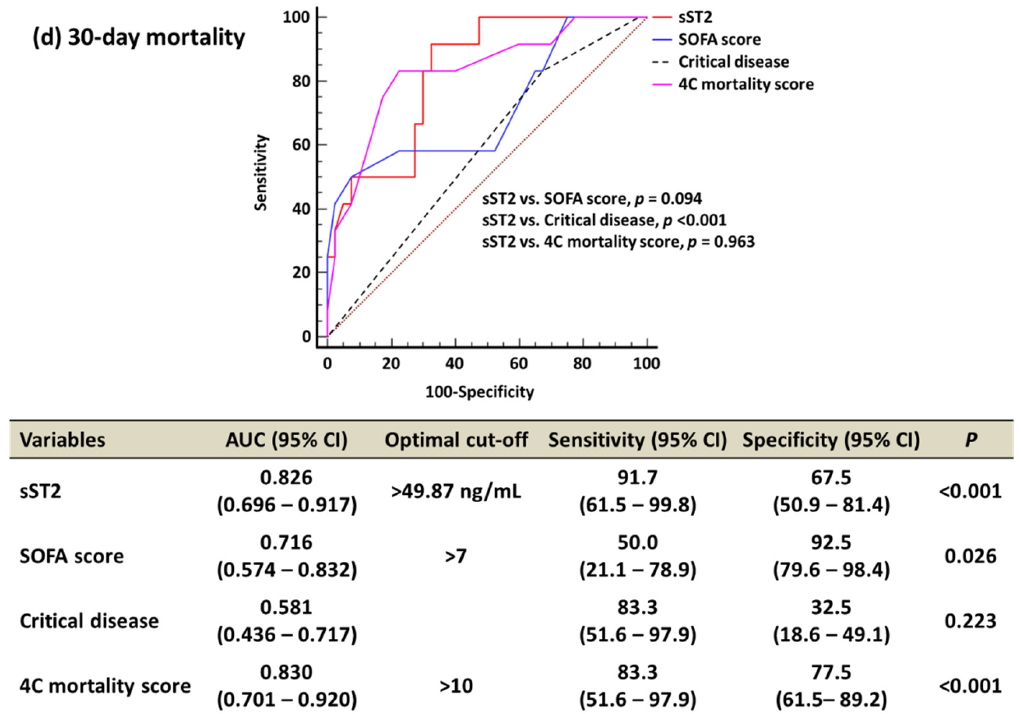
Figure 2. Receiver operating characteristic curve analysis of sST2, SOFA score, critical disease, and 4C mortality score for clinical outcomes. ( a ) ICU admission. ( b ) Ventilator use. ( c ) ECMO use. ( d ) 30 ‐ day mortality. Abbreviations: sST2 — soluble suppressor of tumorigenicity 2; SOFA — sequential organ failure assessment; AUC — area under the curve; CI — confidence interval.